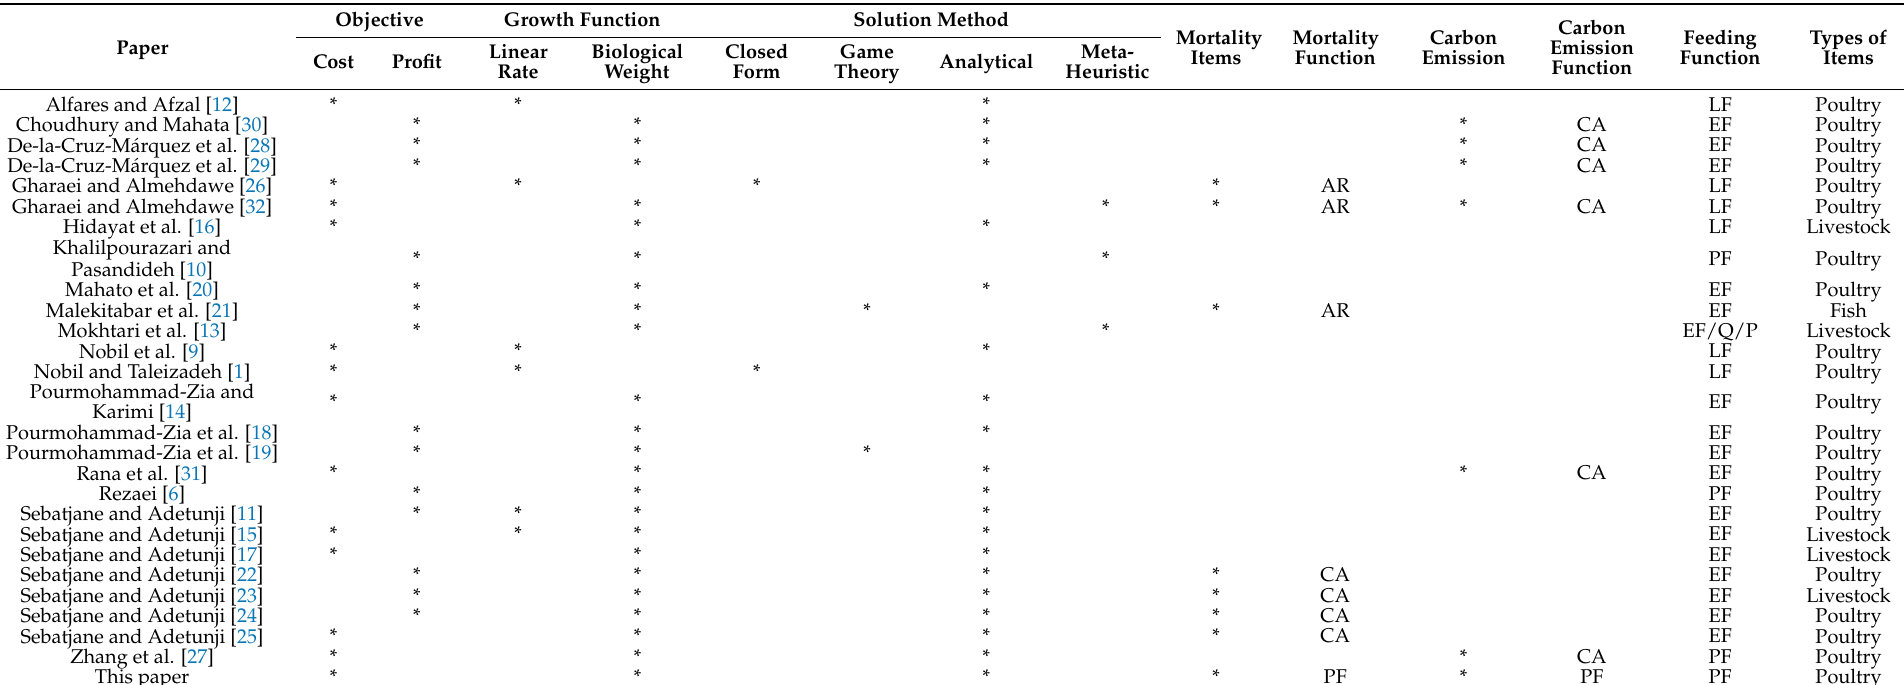
Table 1. The proposed EGQ model compared with related